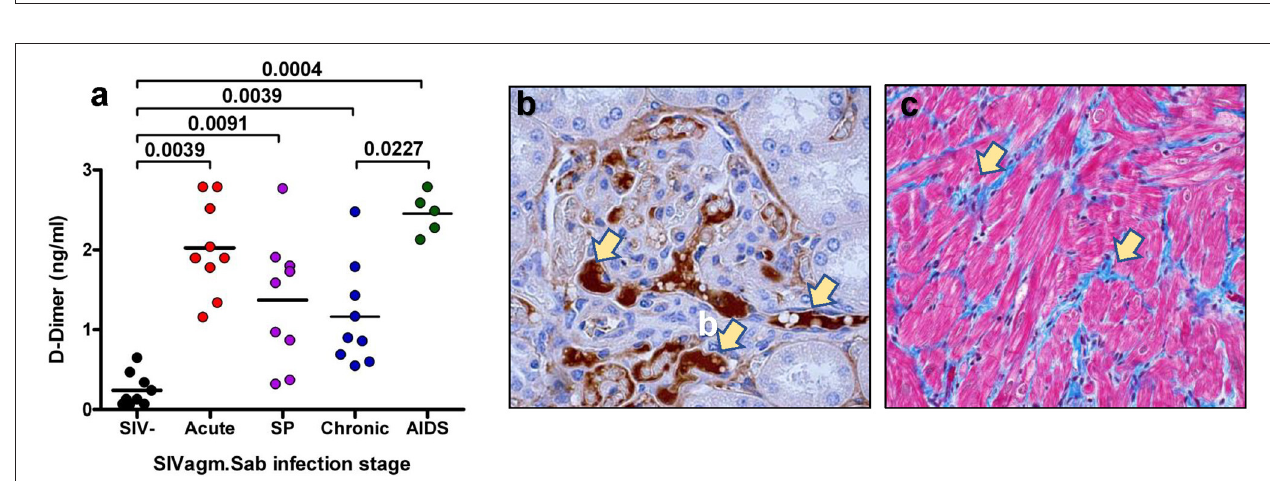
FIGURE 3 | Coagulation disorders during SIV infection. (a) Changes in the levels of D-Dimer assessed at critical time points of SIVsab infection in pigtailed macaques. SP indicates set point. P -values were calculated with the paired t -test. (b) Thrombotic microangiopathy (TMA) during the pathogenic SIVsab infection of PTMs. Immunohistochemistry for fibrinogen (brown) in the kidney. (c) Fibrosis of the heart characterized by increased diffuse deposition of collagen (blue) replacing drop-out or lysed myocytes. Trichrome staining. The original magnification of all pictures was 400x. Reproduced with authorization from Pandrea et al. (42).